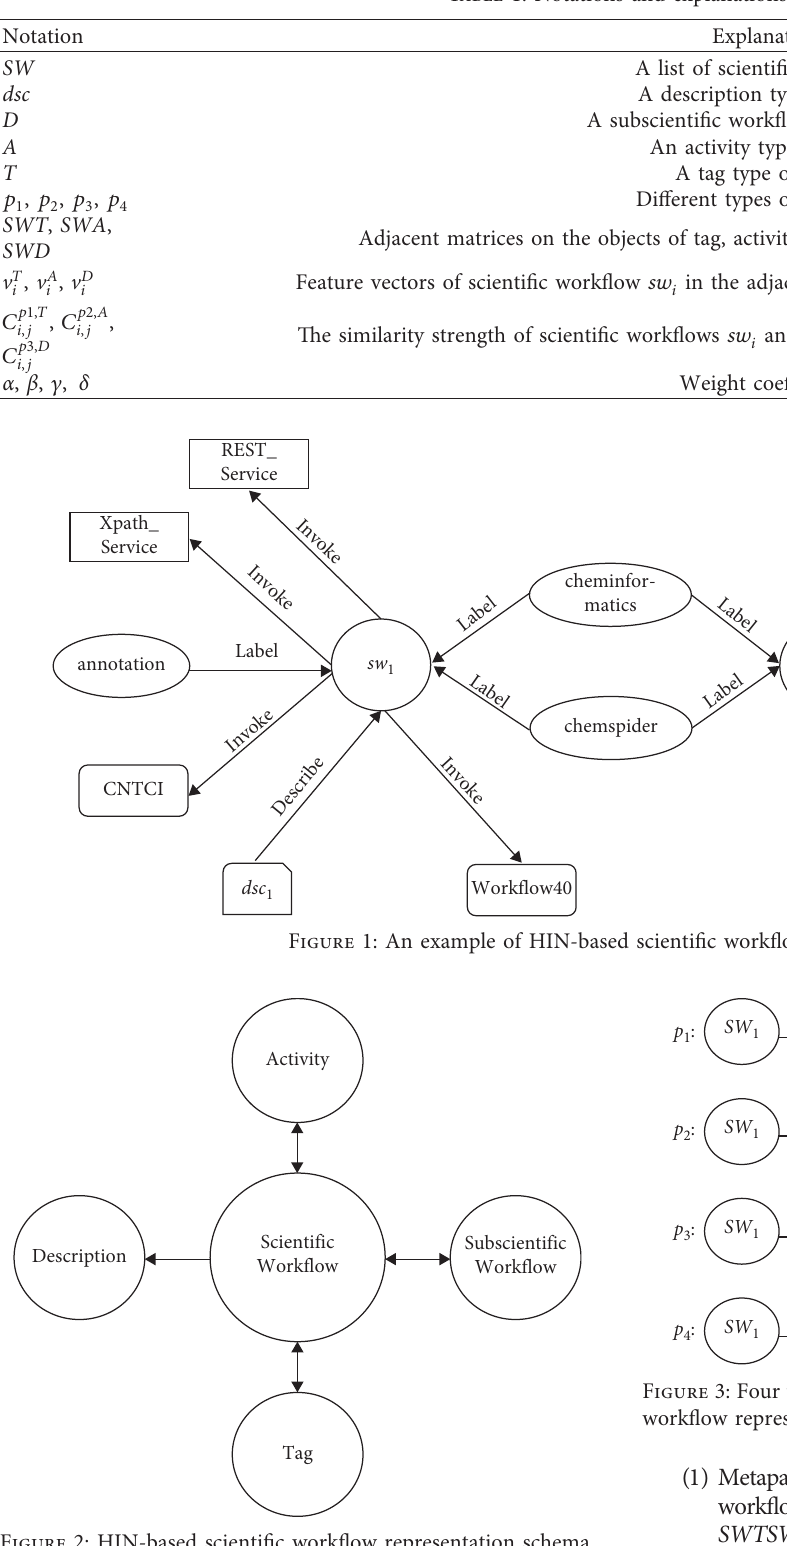
Table 1: Notations and explanations.